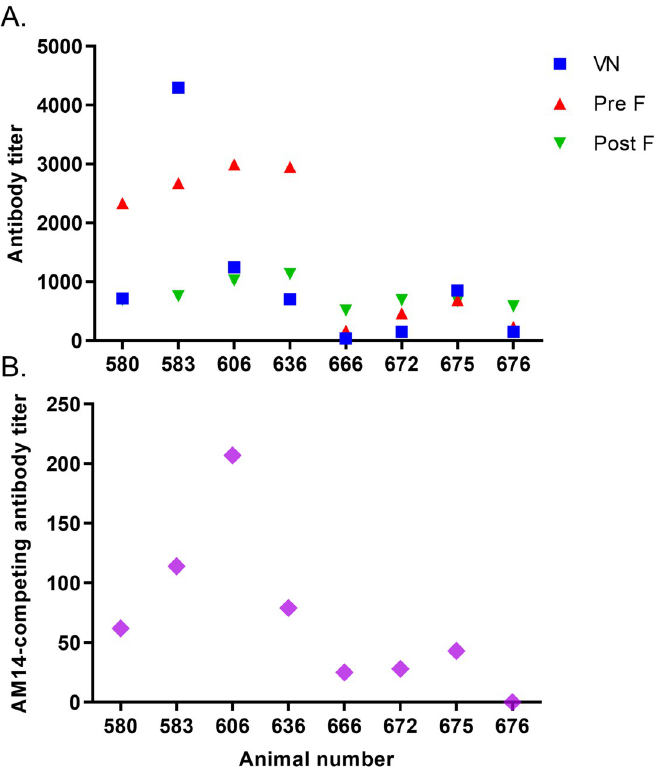
Fig 11. Primary antibody responses and memory responses to BRSV, 2.5 months after (re)infection in March 2020. (A) BRSV-neutralising antibodies (VN), BRSV-Pre F-specific IgG1 antibodies (Pre F), BRSV-Post F-specific IgG1 antibodies (Post F) and BRSV-specific IgG1 (BRSV lysate) in serum of cattle obtained in June 2020. (B) AM14 (reactive to a prefusion trimer-specific epitope on the PreF)-competing antibodies in the same animals and time